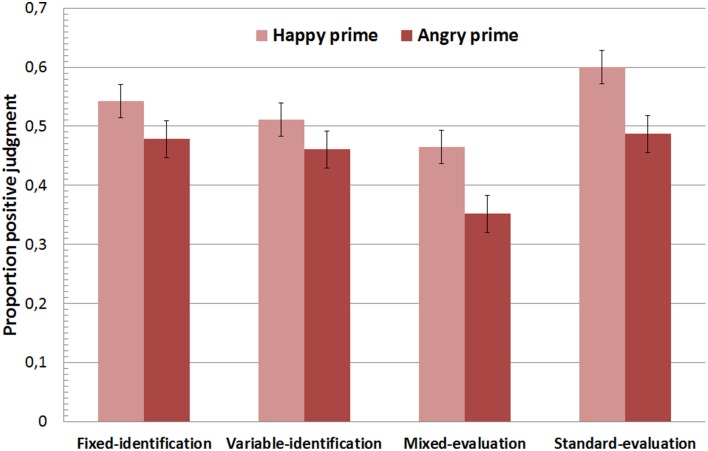
Proportion of positive categorizations of nonsense targets as a function of affective prime and experimental condition. Error bars display the 95% CI of the mean value.